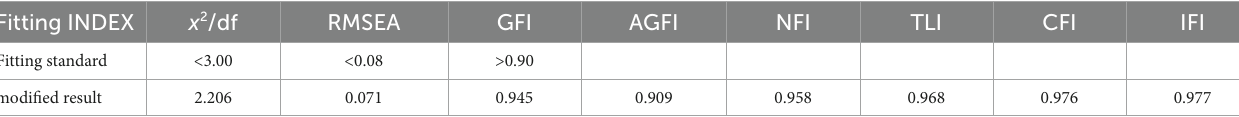
TABLE 6 Fit indices of the models. Fitting